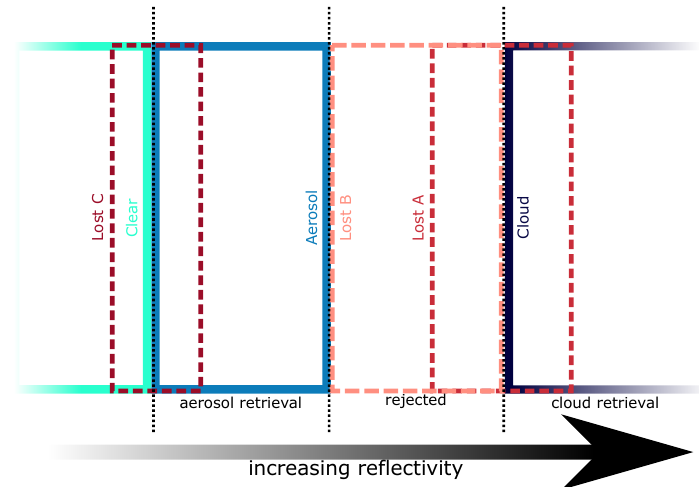
Figure 9. Schematic placement of the ”Lost” classes relative to aerosol and cloud retrievals with increasing reflectivity (based on [6]); colors of each class correspond to those used in Figure